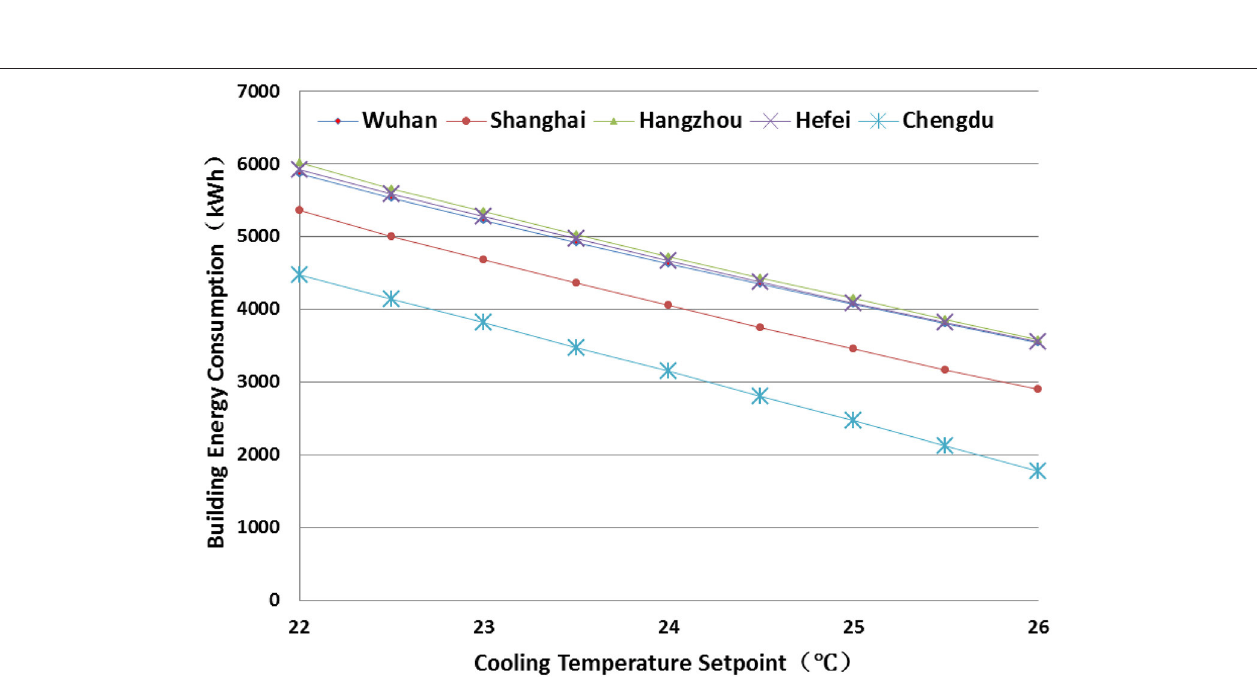
FIGURE 8 | Sensitivity analysis of cooling temperature setpoint on annual energy